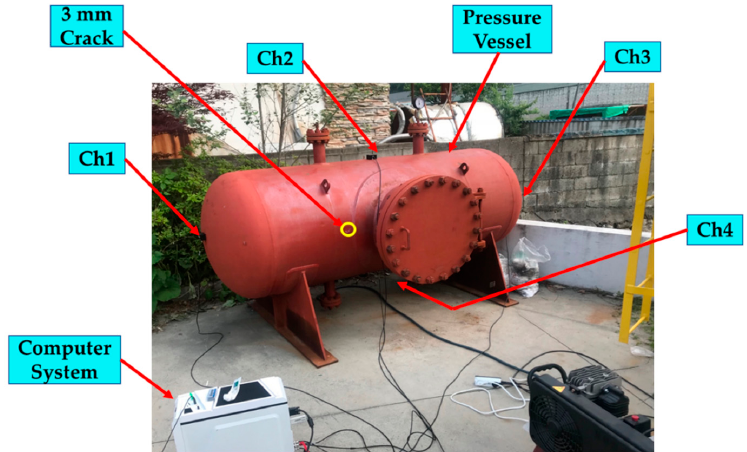
Figure 2. Pressure vessel test rig and its component locations that were used for data acquisition.